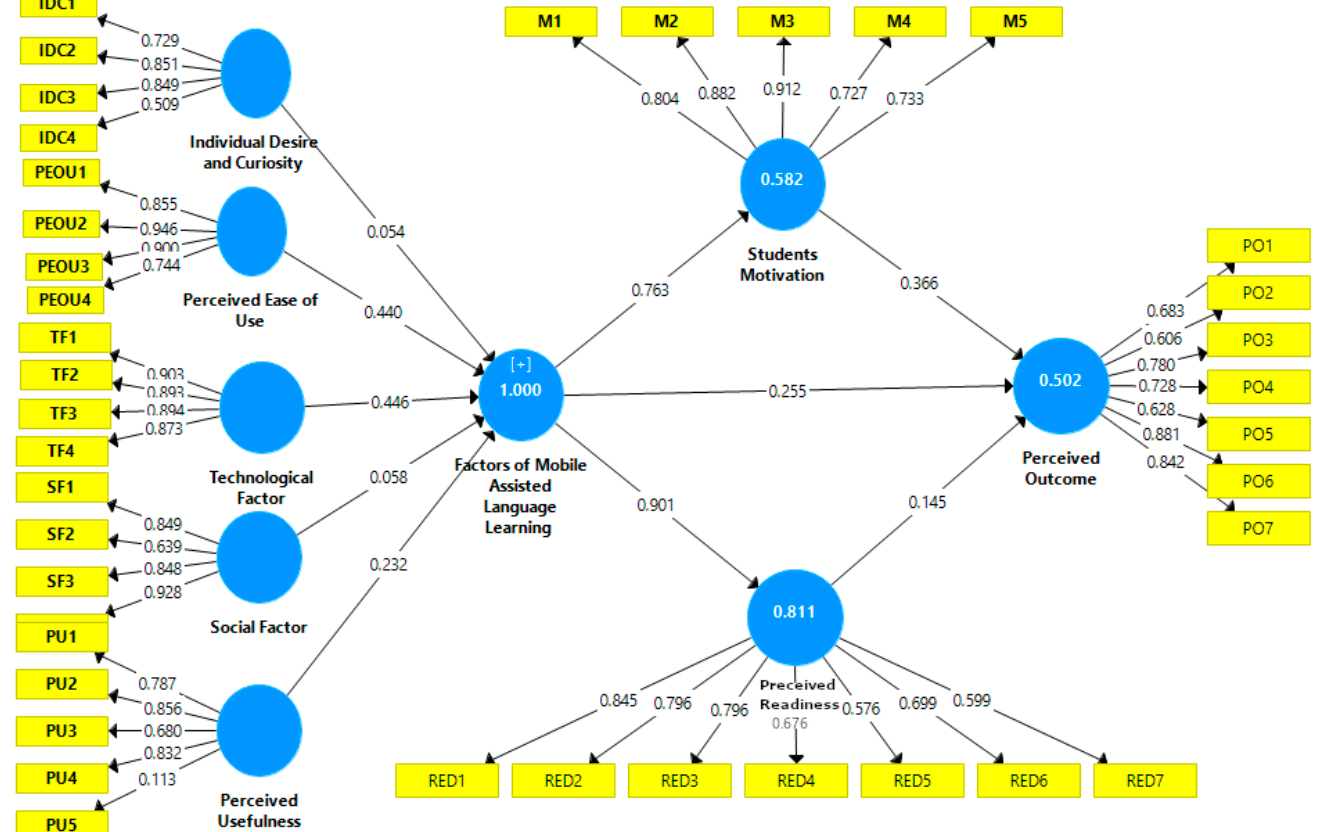
Figure 2. PLS-SEM Model and statistical outcome.